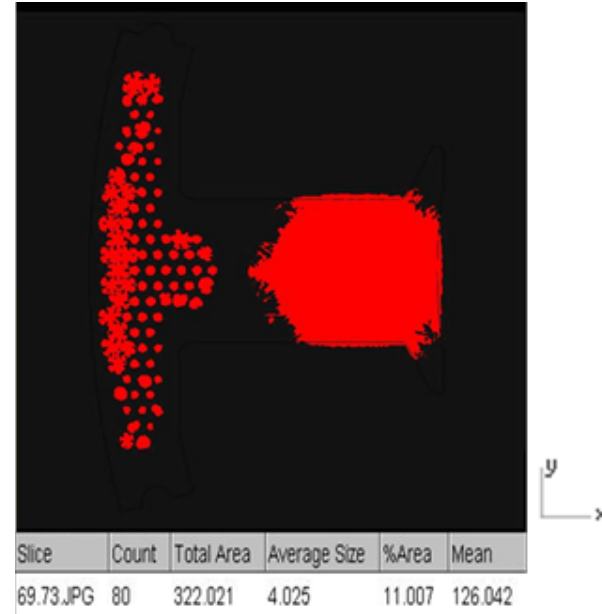
Figure 14. ImageJ measurement